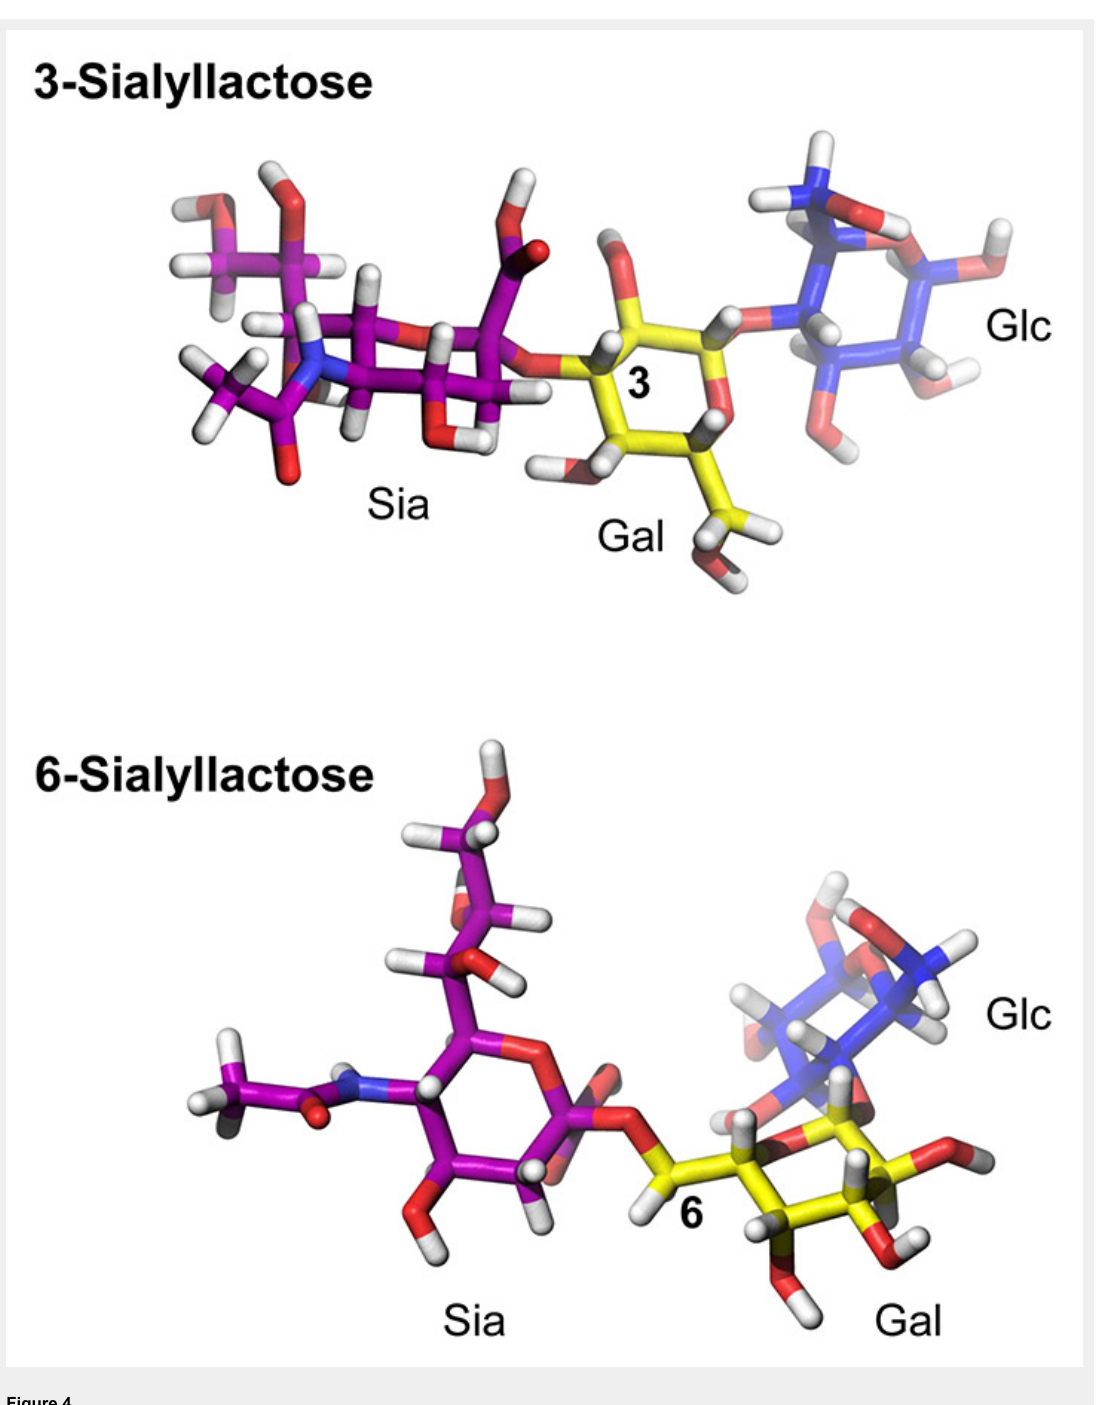
Figure 4 Structure of 3–sialyllactose and 6–sialyllactose. The three-dimensional structures point to the extended configuration of 3–sialyllactose and bent configuration of 6–sialyllactose. The positions of the third and sixth C-atoms of galactose (Gal), to which sialic acid (Sia) is attached are marked with the numbers 3 for 3–sialyllactose and 6 for